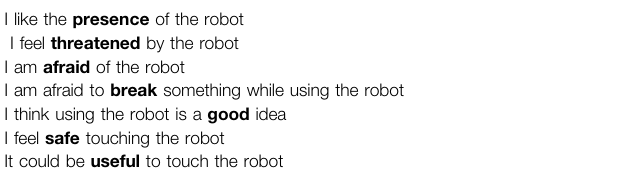
TABLE 1 | The seven questions in the robot acceptance survey asked in both the opening and closing evaluations.